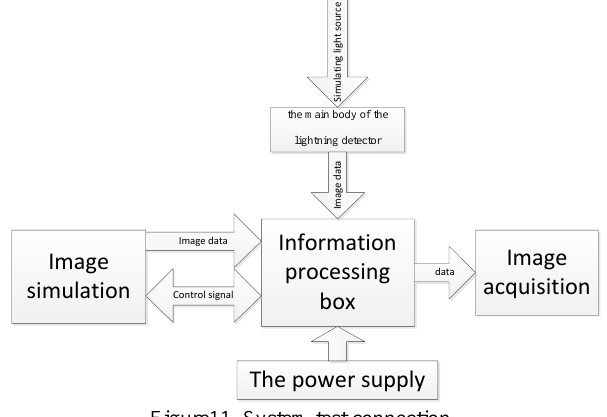
Figure11. System test connection